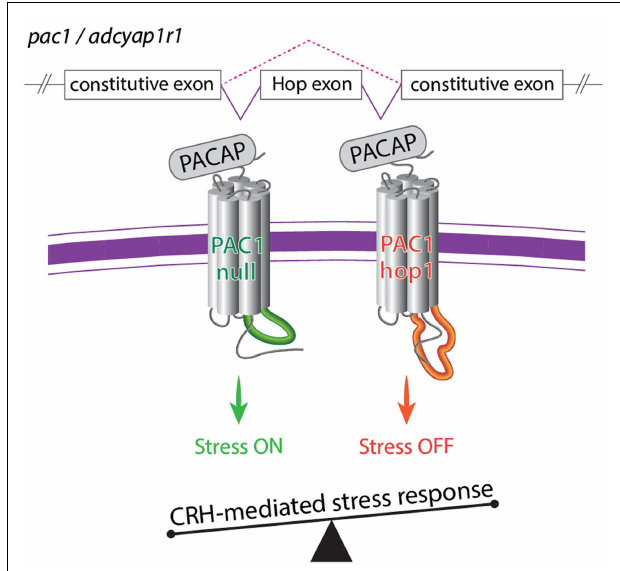
FIGURE 6 |A model illustrating the role of alternative splicing of PAC1 hop cassette that serves as an ON/OFF stress switch . In response to various stressors, the so called PAC1-null splice variant (i.e., no deletion in the N-terminal domain and no addition to the intracellular loops) modulate transcriptional activation of CRH and stress behaviors to adapt to the changes in homeostasis.Termination of CRH-mediated stress response is mediated by means of regulation of PAC1 gene splicing and inclusion of an altered exon (hop1) encoding to 28 amino acids of the third intracellular loop leading to the formation of the PAC1-hop1 splice variant. Generation of the PAC1-hop isoform terminates stress response by means yet to be uncovered (see text and Amir-Zilberstein et al.,